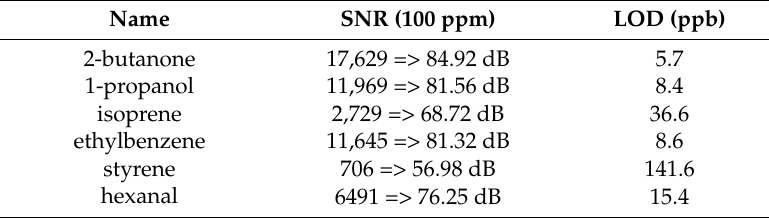
Table 2. Detection limits for lung cancer